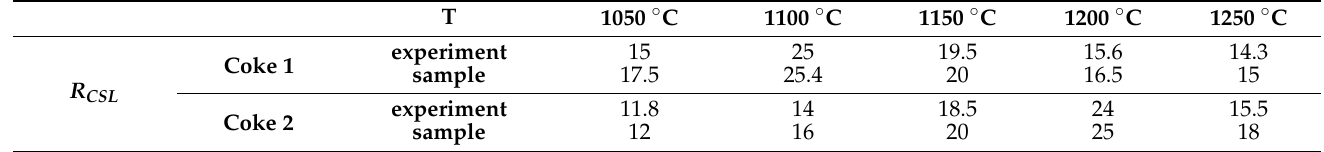
Table 6. Coke dissolution loss rate, %.